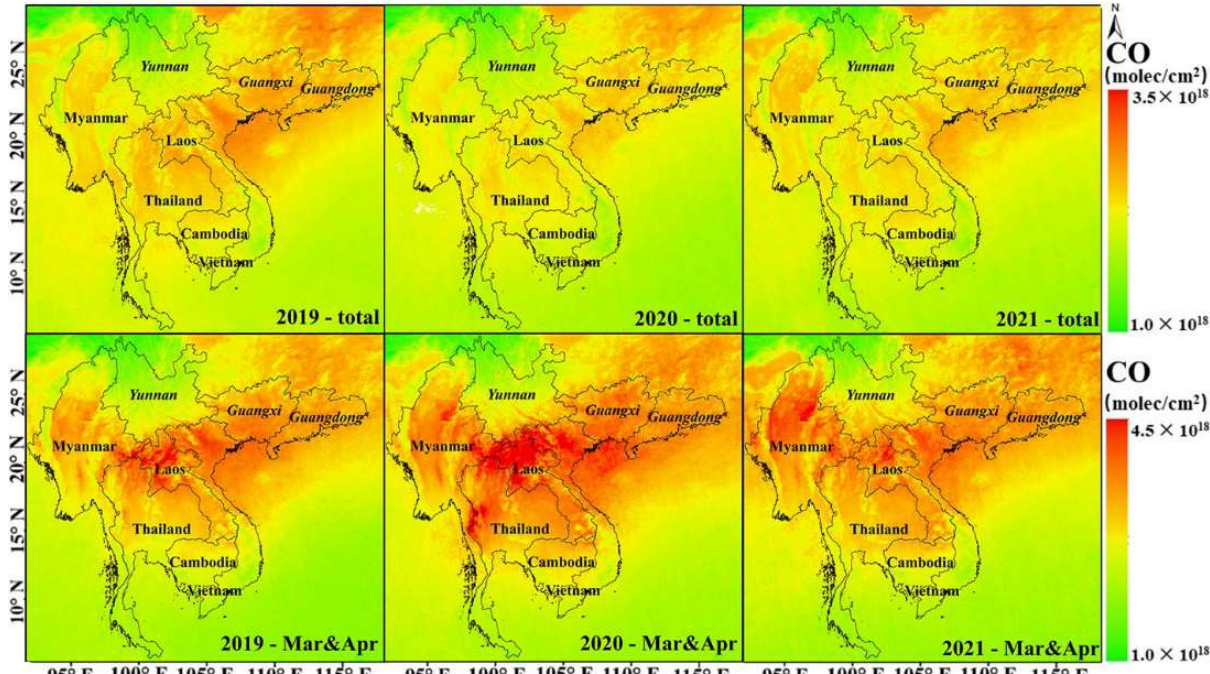
Figure 4. S5P TROPOMI CO column concentration changes in study area from 2019 to 2021.